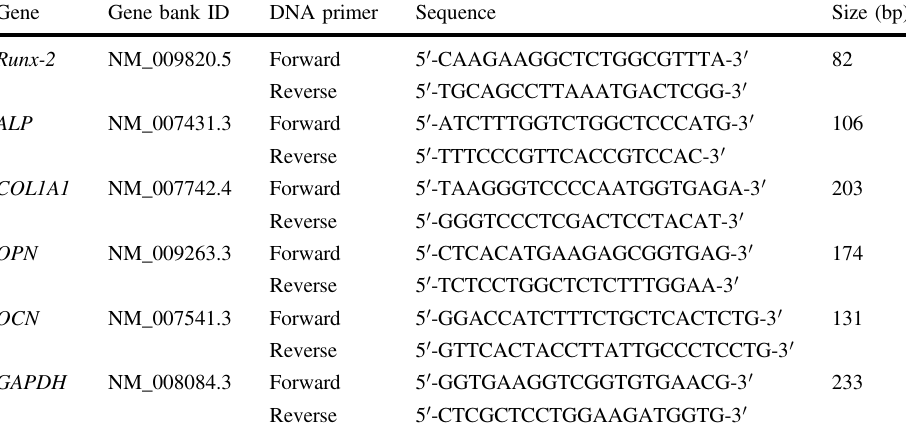
Gene Gene bank ID